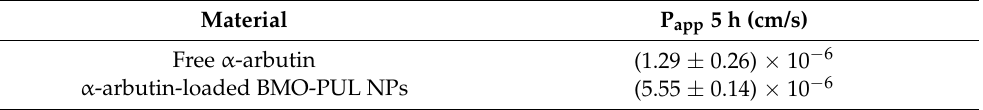
Table 6. Experimental permeability coefficients (P app ) of BMO-PUL nanoparticles through HaCaT cell monolayers at 5 h incubation time ( n = 5; ± SD).